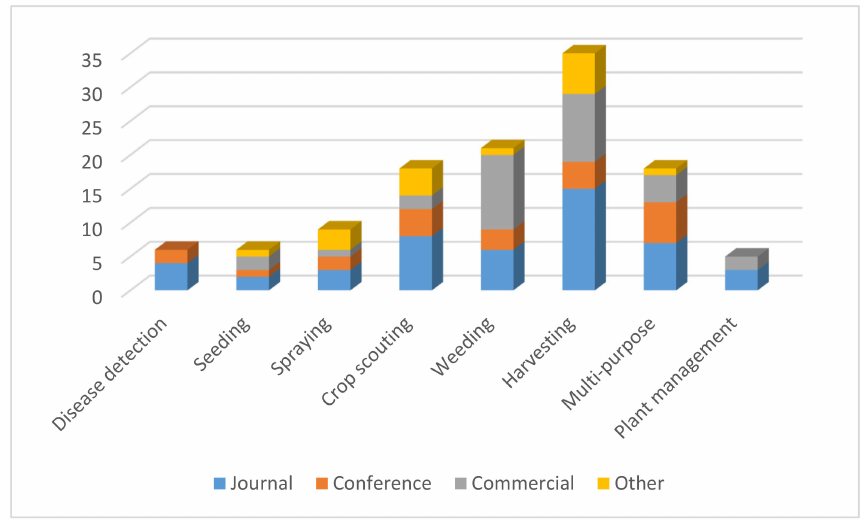
Figure 4. Number of reviewed robots per field